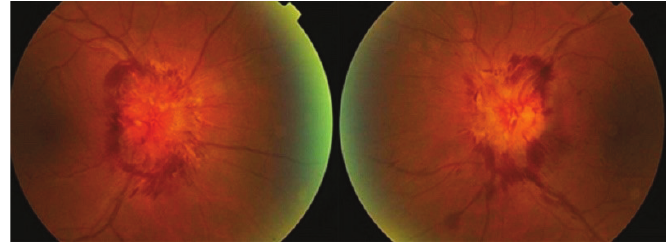
Figure 1. Fundus photographs show significant hyperemia and edema of both optic discs.